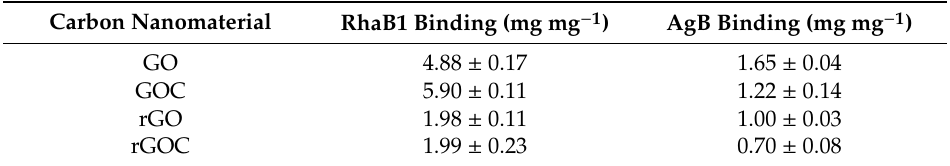
Table 2. Maximum binding capacity (%) of GO, GOC, rGO, and rGOC using different carbohydrate active enzymes.